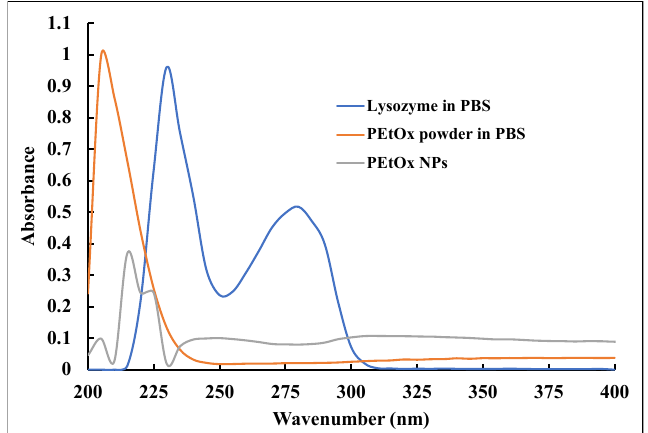
Figure 13. UV–Vis spectra of PEtOx solution (16 µg/mL) in PBS, PEtOx NPs in PBS (16 µg/mL), and lysozyme solution (0.2 mg/mL) in PBS (pH 7.4) PBS was used as the reference.